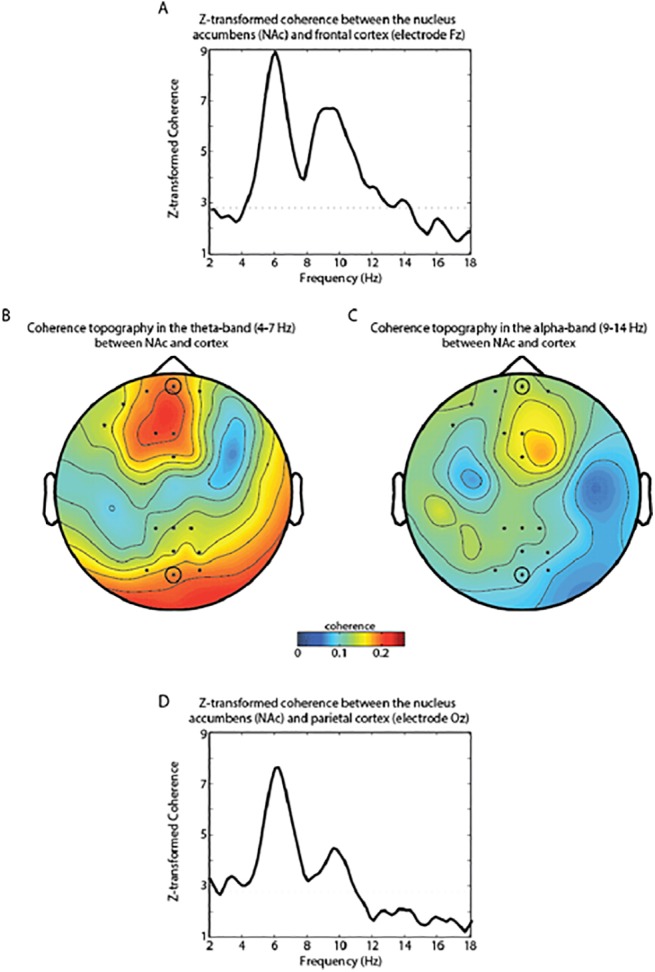
Coherence between the nucleus accumbens (NAc) electrodes and the scalp EEG.
A Z-transformed coherence spectrum between nucleus accumbens and frontal scalp electrode Fz. The horizontal dotted line (Z = 2.8) indicates the threshold of the coherence calculated from data shuffled over trials (see Methods). Coherence values between 4 Hz and 14 Hz are above this threshold. Electrodes Fz and Oz are circled. B Coherence in the theta-band showed a strong frontal topography and a weaker parieto-occipital topography. C Coherence in the alpha-band was strongest around frontal electrodes. The *’s indicate scalp electrodes that were significantly coherent between 4–14 Hz with nucleus accumbens when controlling for multiple comparisons over electrodes and frequency bins using a cluster randomization approach. A strong frontal and a weaker parietal cluster emerged. D Example of coherence in the parietal cluster. The Z-transformed coherence spectrum between nucleus accumbens and occipitoparietal scalp electrode Oz is depicted.